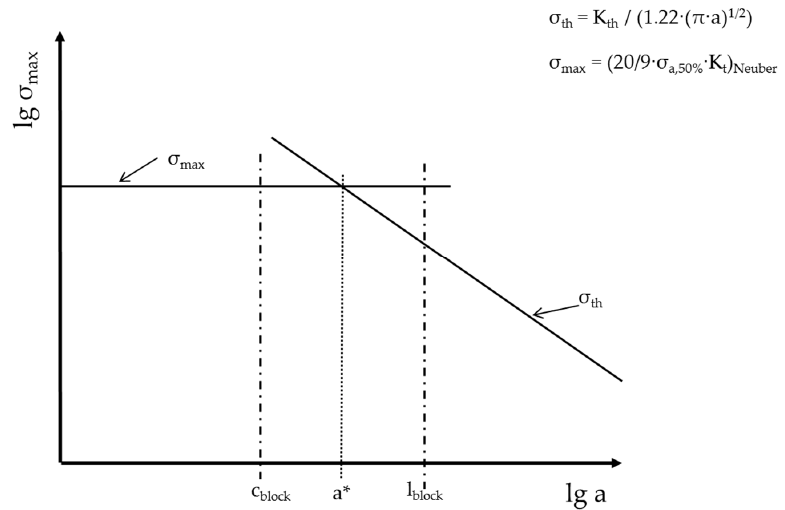
Figure 13. Scheme of Kitagawa diagram drawn with results gathered from crack growth experiments and fatigue tests.